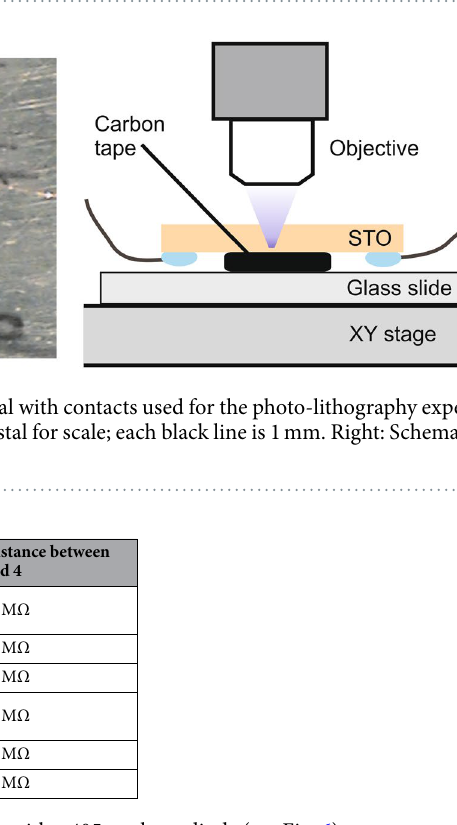
Figure 5. Measured resistance ( R ) versus photogenerated electron density. The electron density was determined from the IR absorbance (ref. 24). The solid line is an estimate of the bulk resistance ( R bulk ) from Eq. (2). The higher values of R suggest that the contact resistance is significant.